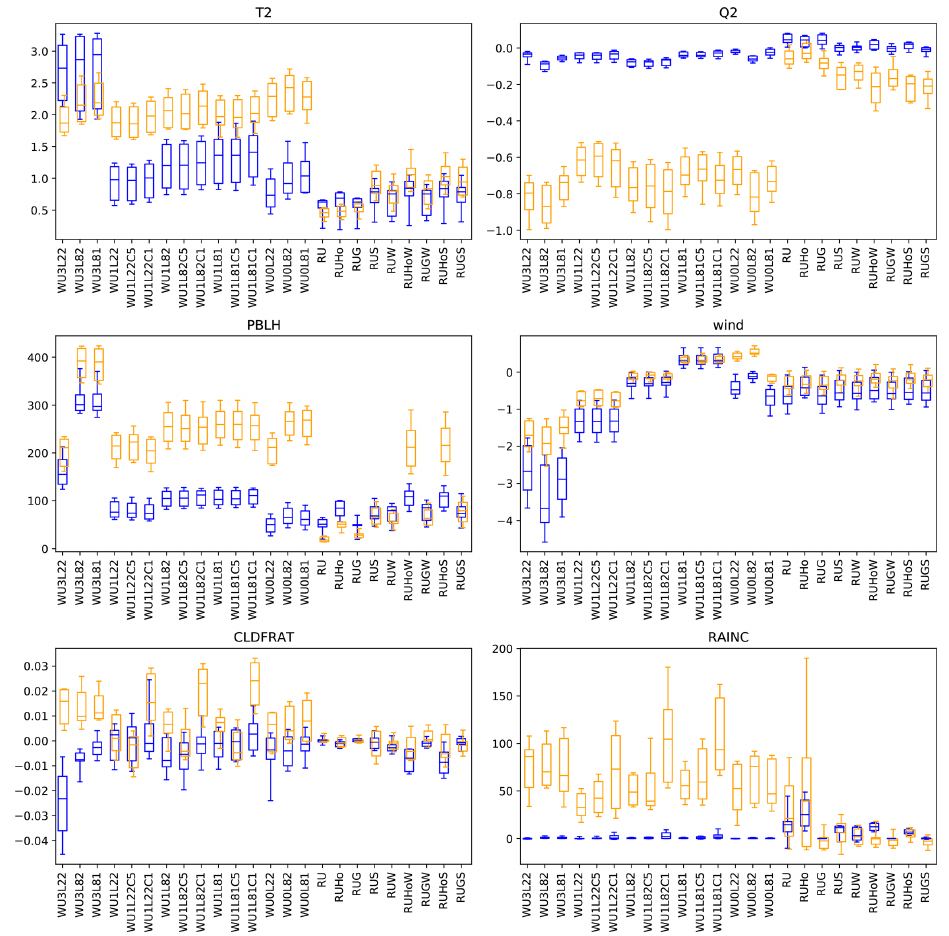
Figure 14. Winter (blue) and summer (orange) differences between city and vicinity values of 2m air temperature ( T 2; in ◦ C), specific humidity ( Q 2; 10 − 3 kgkg − 1 ), boundary-layer height (PBLH; m), wind speed (wind; ms − 1 ), cloud cover (CLDFRAT; fractions of 1) and sub-grid-scale precipitation (RAINC; mm in seasonal sums). Whiskers indicate 5th and 95th